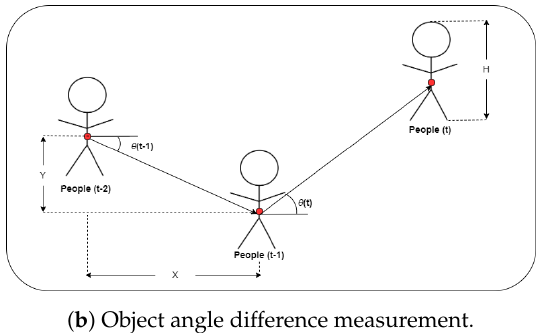
Figure 17. Distance and angle measurement used in method [5].